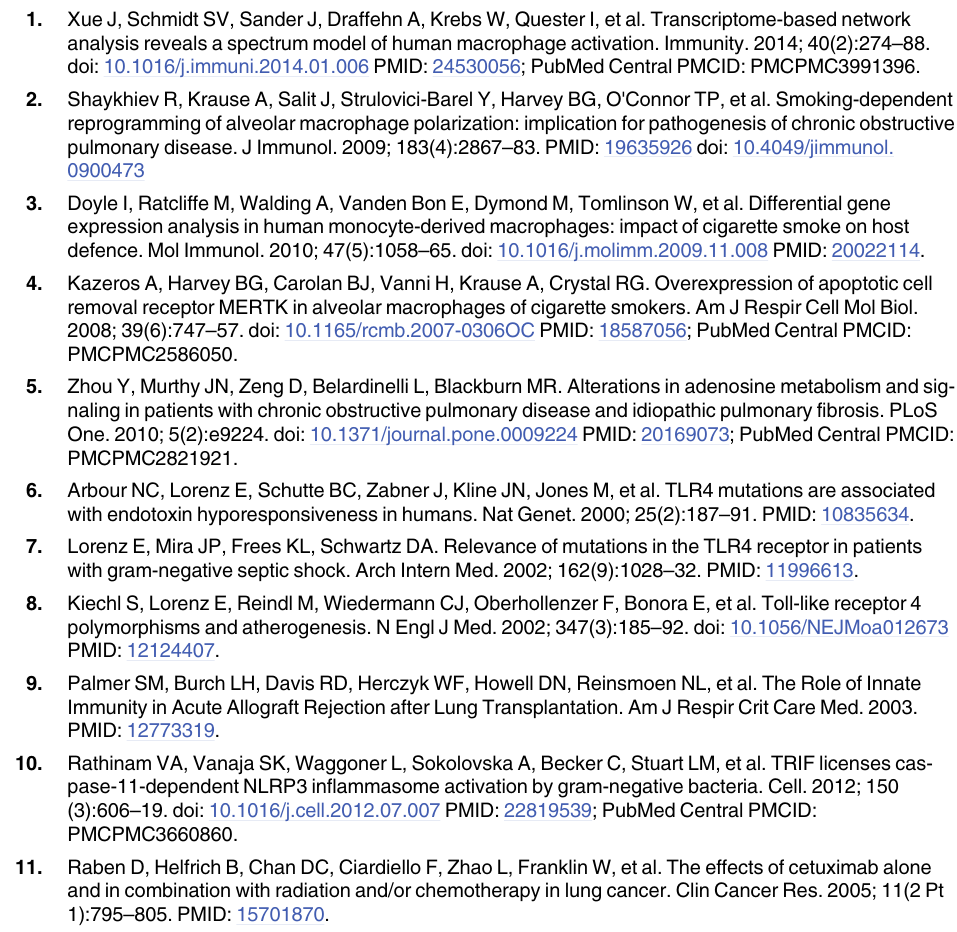
S2 Table. Top 100 up-regulated genes (control vs. LPS, t-test, adjusted p-value < 0 . 05 , Ben- jamini-Hochberg). Values represent mean expression